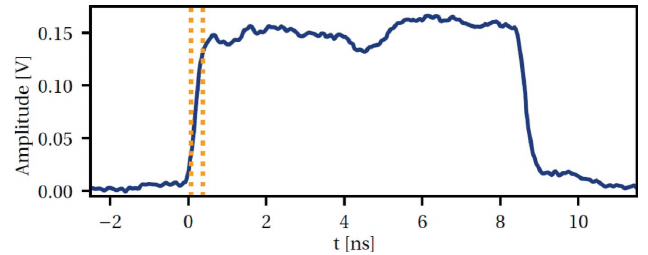
Figure 8 Laser temporal profile recorded with a fast photodiode (EOT ET-3500) connected to a fast oscilloscope (LeCroy WaveMaster 20 GHz). Orange dotted lines represent the rise time between 20 and 80% of the maximum, i.e. 300